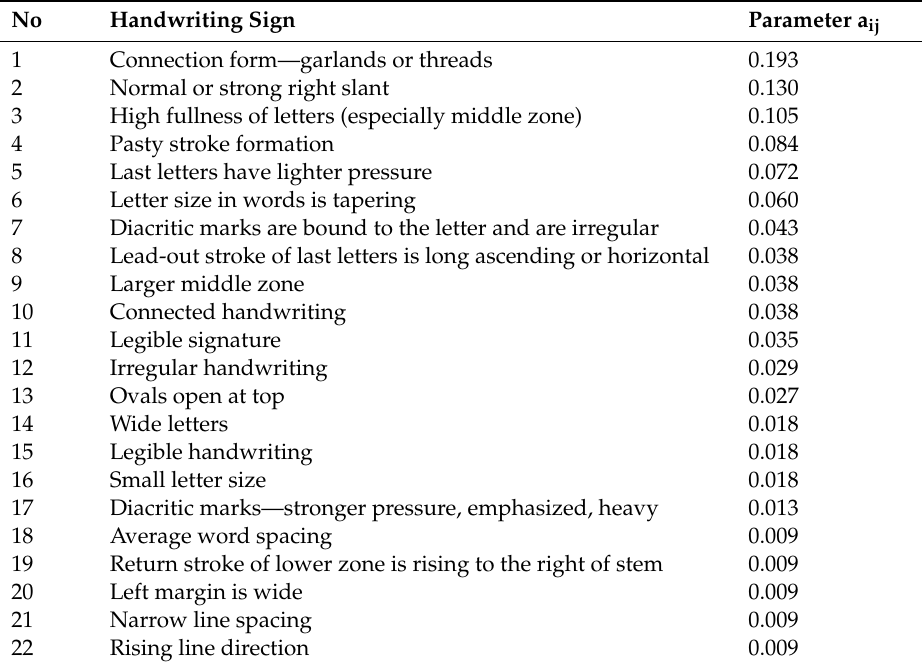
Table 1. Handwriting signs for trait “responsiveness”.